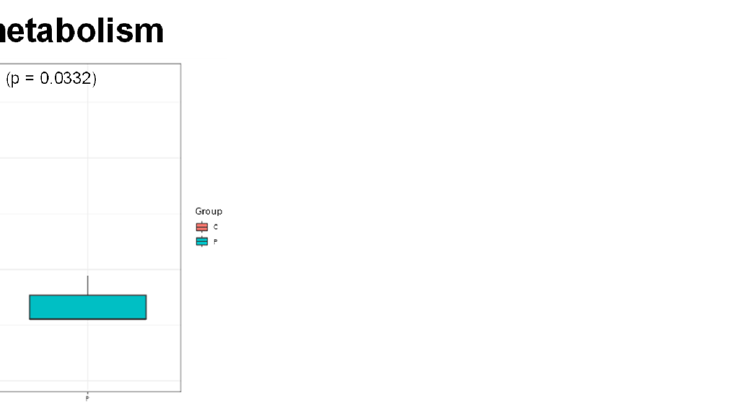
Figure A7. Detailed results of the enrichment analysis in Figure 5c. In each box plot, C and P indicate the data without and with depressive episodes, respectively.